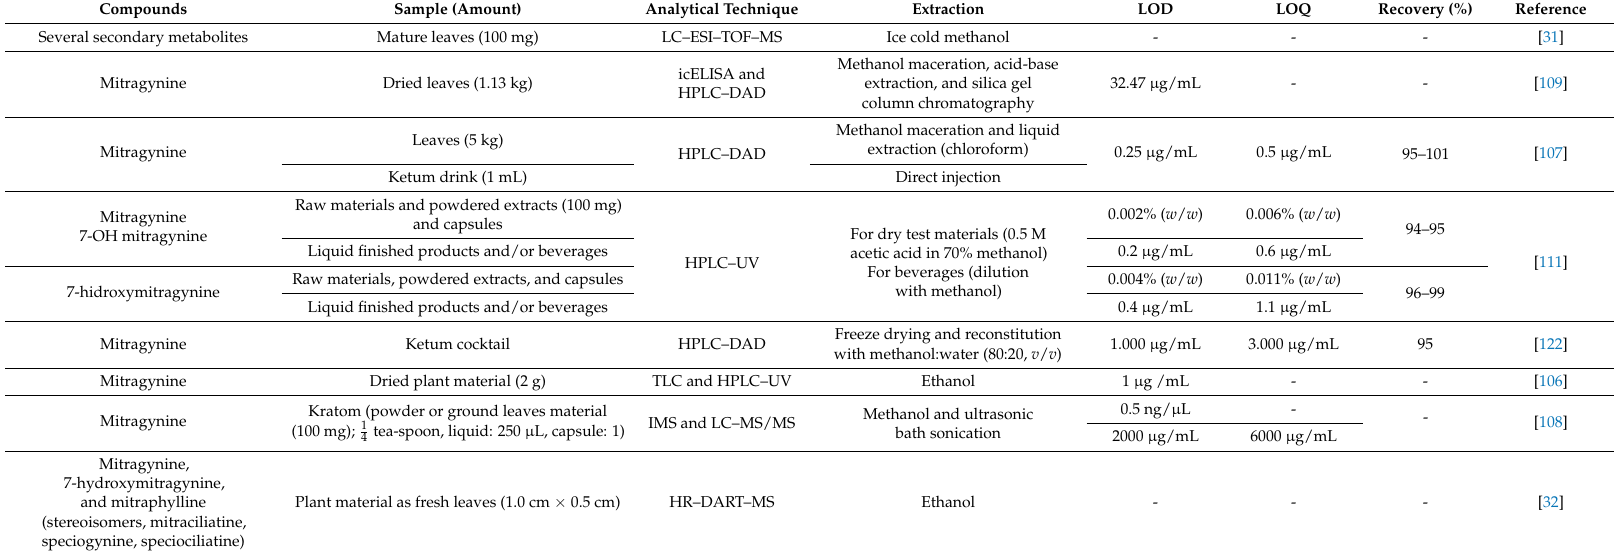
Table 2. Analytical methods for the identification and/or quantification of Mitragyna speciosa in leaves and plant